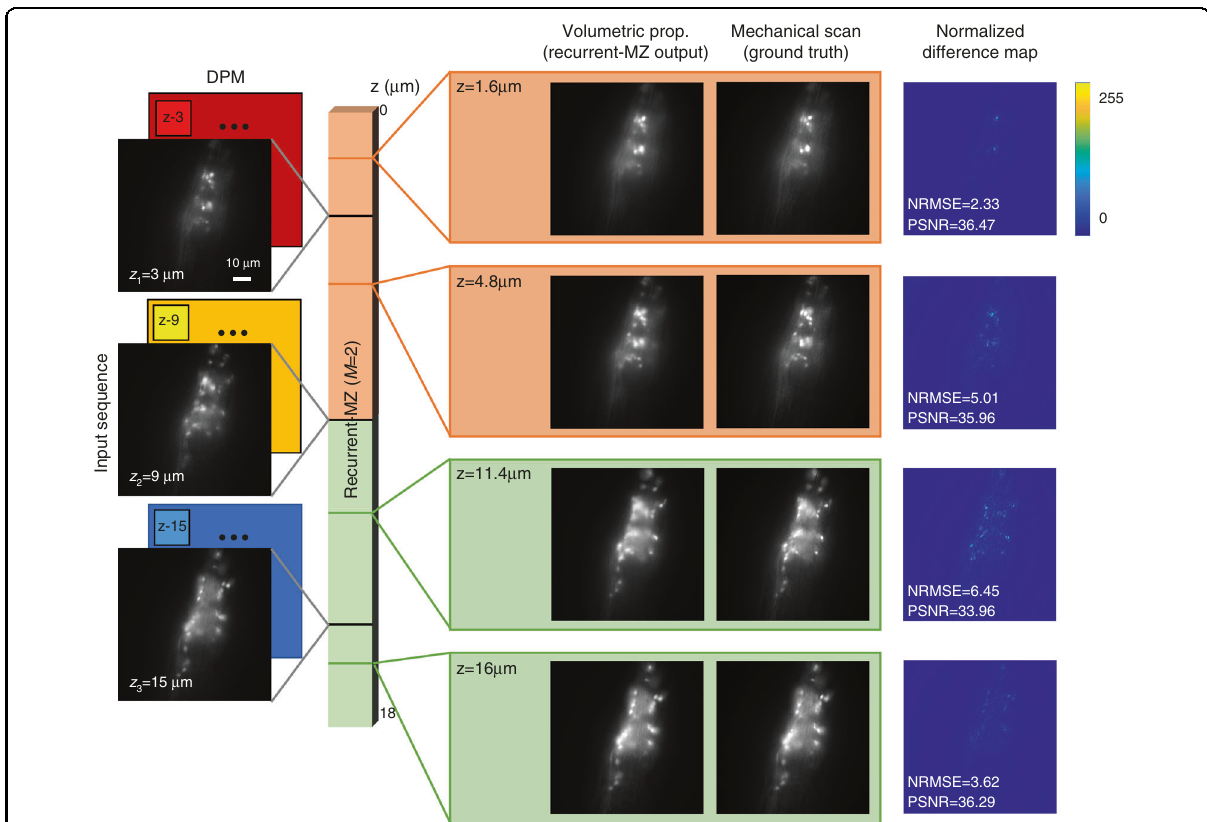
Fig. 2 Volumetric imaging of C. elegans from sparse wide- fi eld scans using Recurrent-MZ. The DPMs in the input sequence are used to de fi ne an arbitrary axial position ( z ) within the sample volume. In this implementation, Recurrent-MZ takes in 2 input scans ( M = 2) to infer the image of an output plane, as indicated by the color of each output box. See Video S1 to compare the reconstructed sample volume inferred by Recurrent-MZ against the ground truth, |Z| = 91 images captured with an axial step size of 0.2 μ